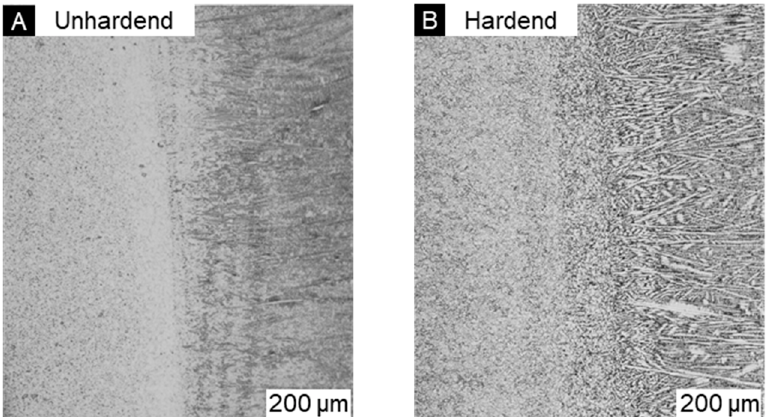
Figure 5. Microscopic image of the micro-structure of the heat transition zone before ( A ) and after the hardening process ( B ). the hardening process ( B Table 3. Characteristics of the material defects.